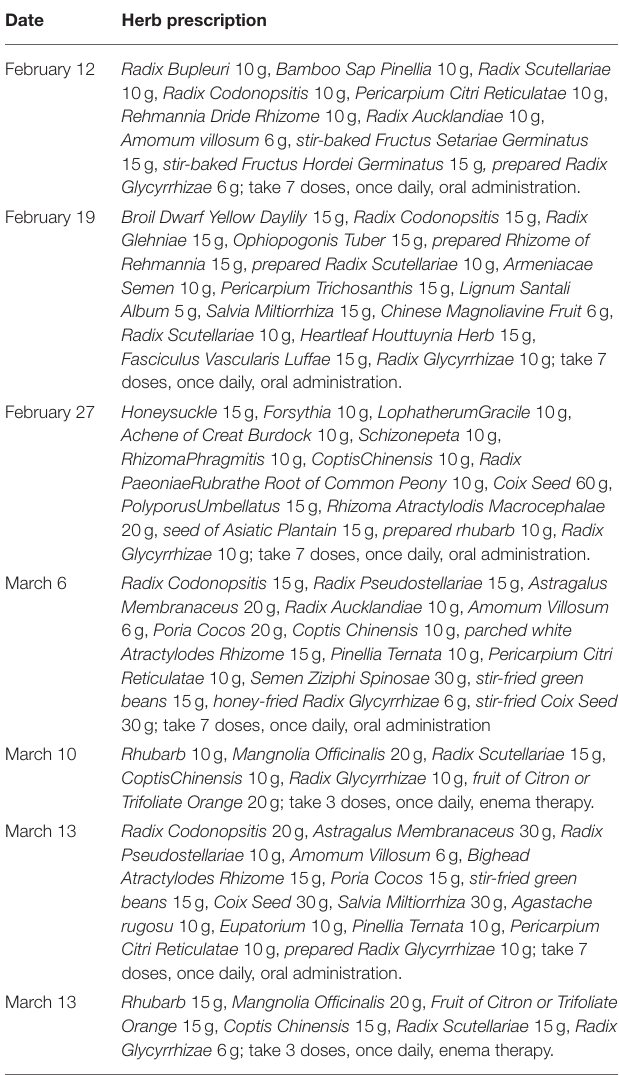
TABLE 1 | Traditional Chinese medicine prescriptions from February 12 to March 13,